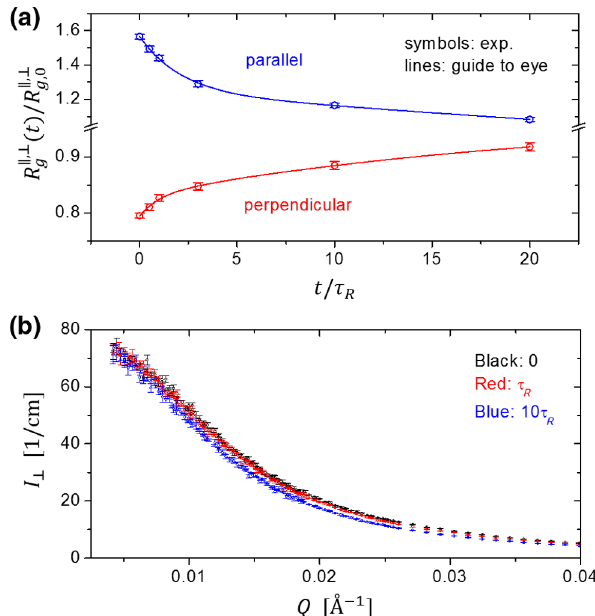
FIG. 6. (a) Evolution of the radius of gyration in the parallel and perpendicular directions to stretching. R ∥ equilibrium radius of gyration in the parallel and perpendicular directions, respectively. Obviously, R ∥ the absolute scattering intensity in the perpendicular direction. The SANS data are collected on the NGB30 SANS beam line at